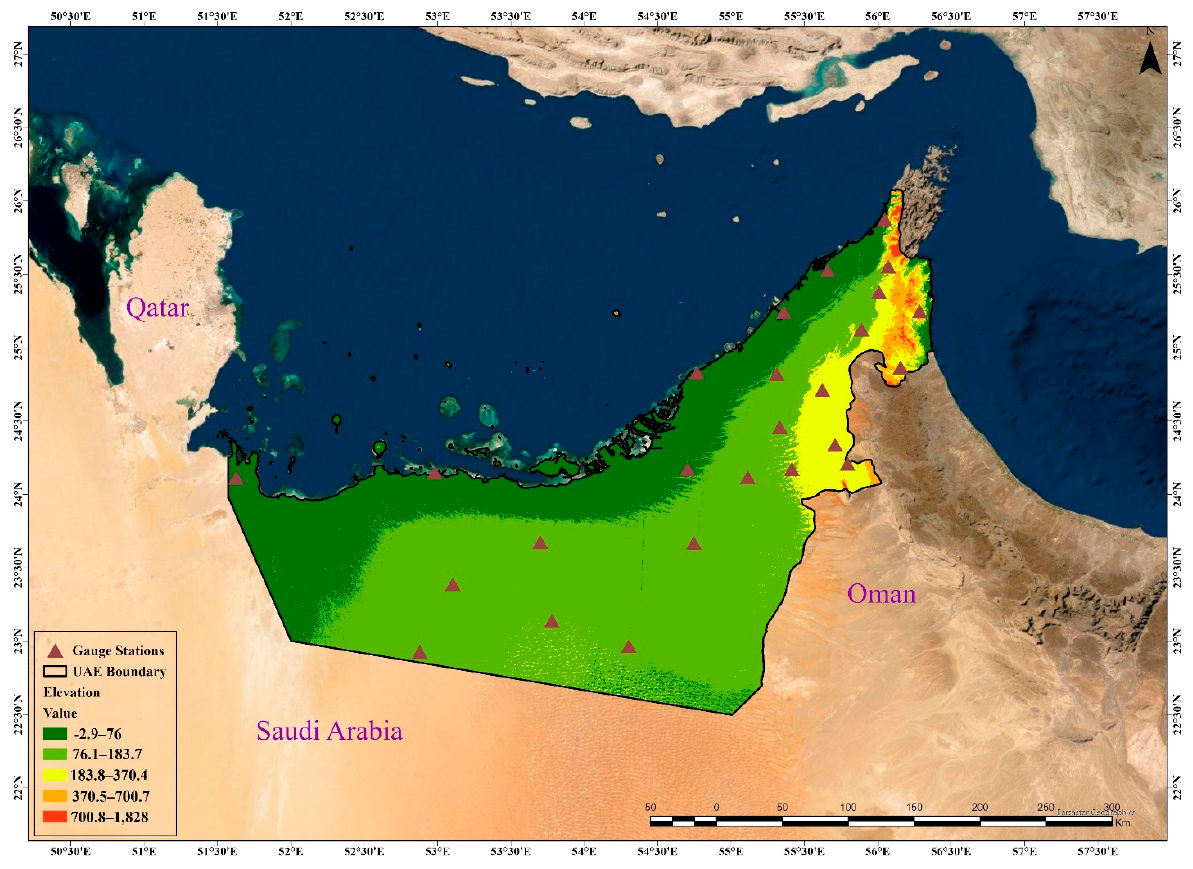
Figure 1. The geographical location of the United Arab Emirates with elevation map and the gauge locations used in this study.